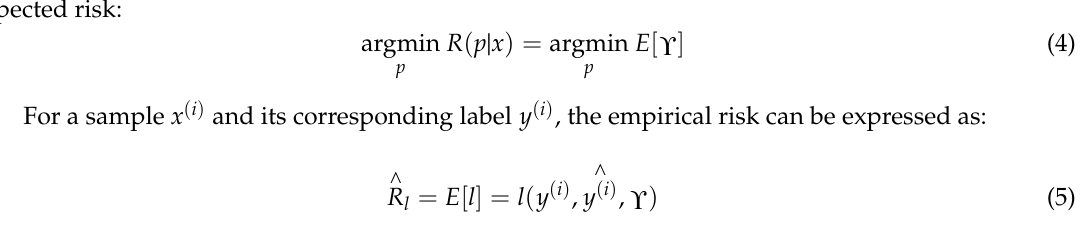
Table 1. Cost matrix for binary classification.